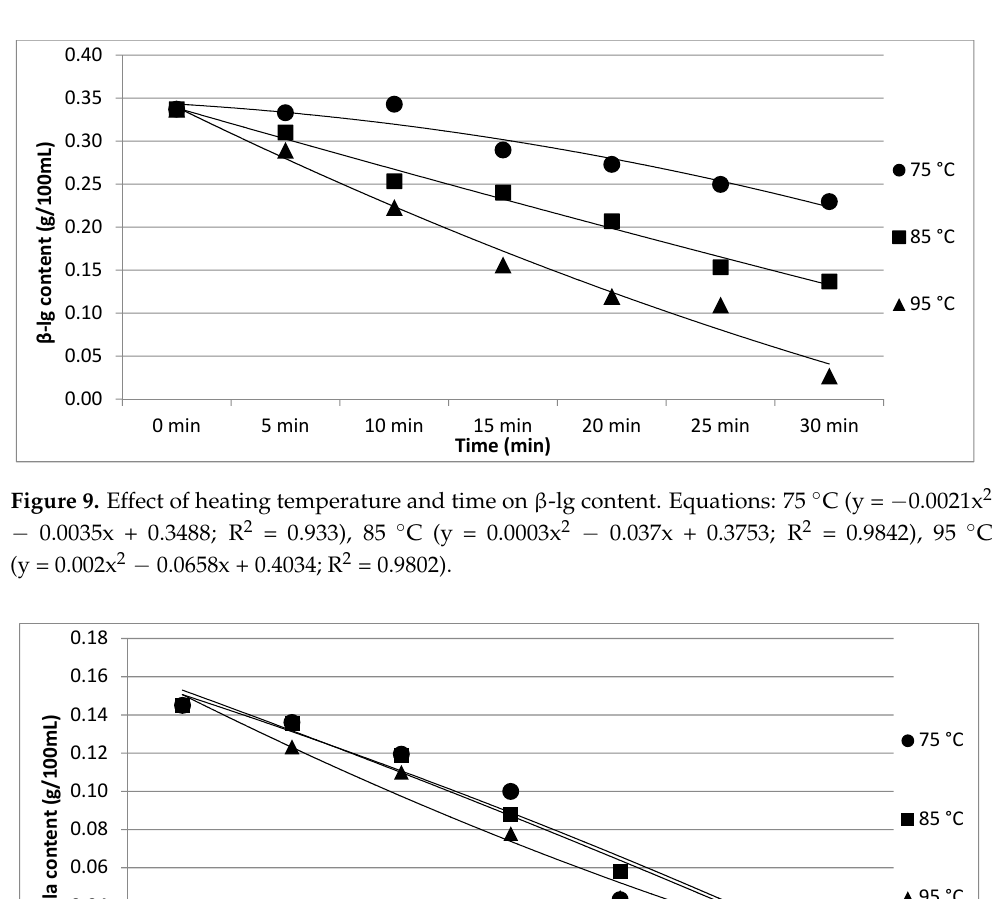
Figure 8. Effect of heating temperature and time on κ -cas content. Equations: 75 °C (y = − 0.0014x 2 − 0.0128x + 0.3089; R 2 = 0.9616), 85 °C (y = − 0.0057x 2 + 0.0198x + 0.2638; R 2 = 0.9764), 95 °C (y = − 0.0032x 2 − 0.0082x + 0.2995; R 2 = 0.9727).